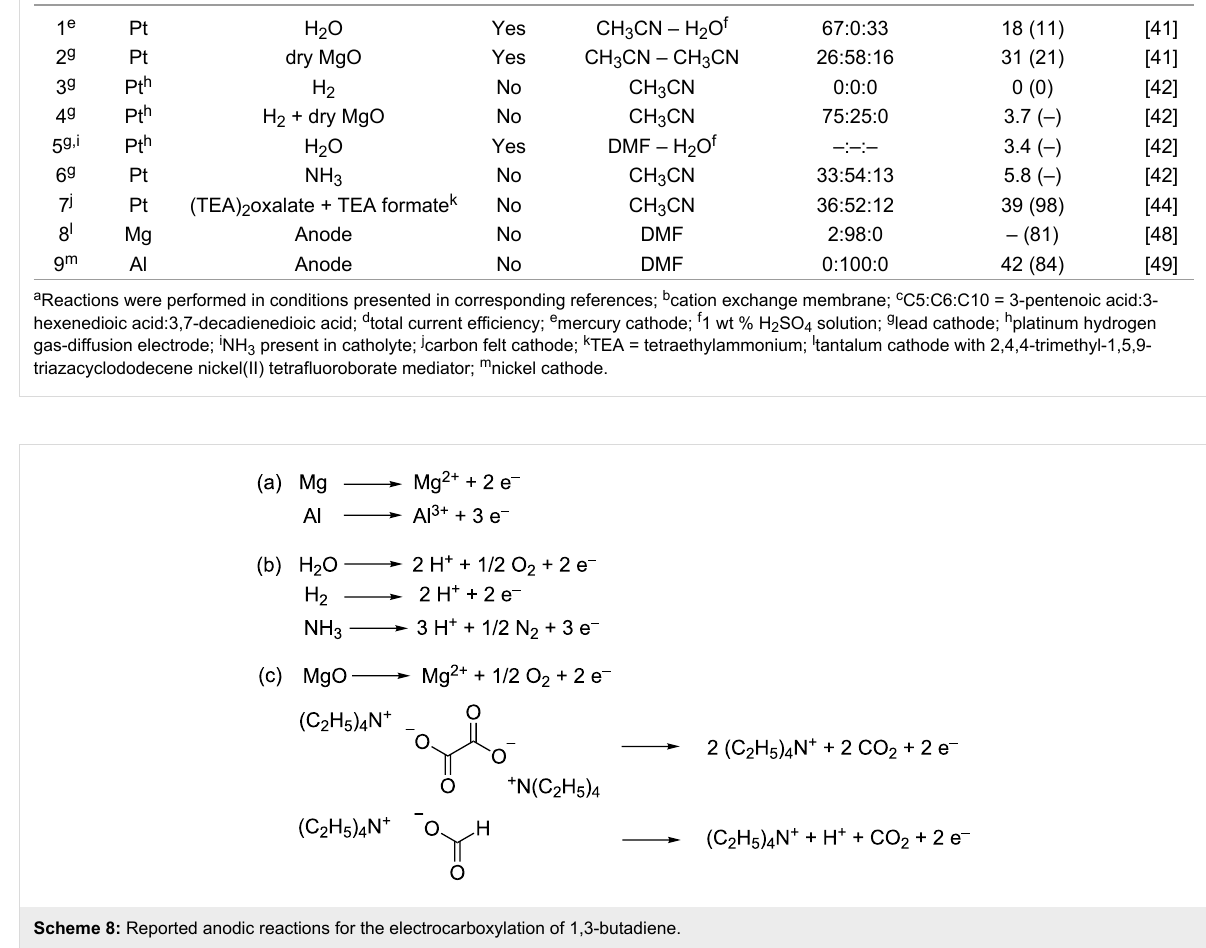
Solvent C5:C6:C10 c η d (%) (Yield (%)) (catholyte – anolyte)